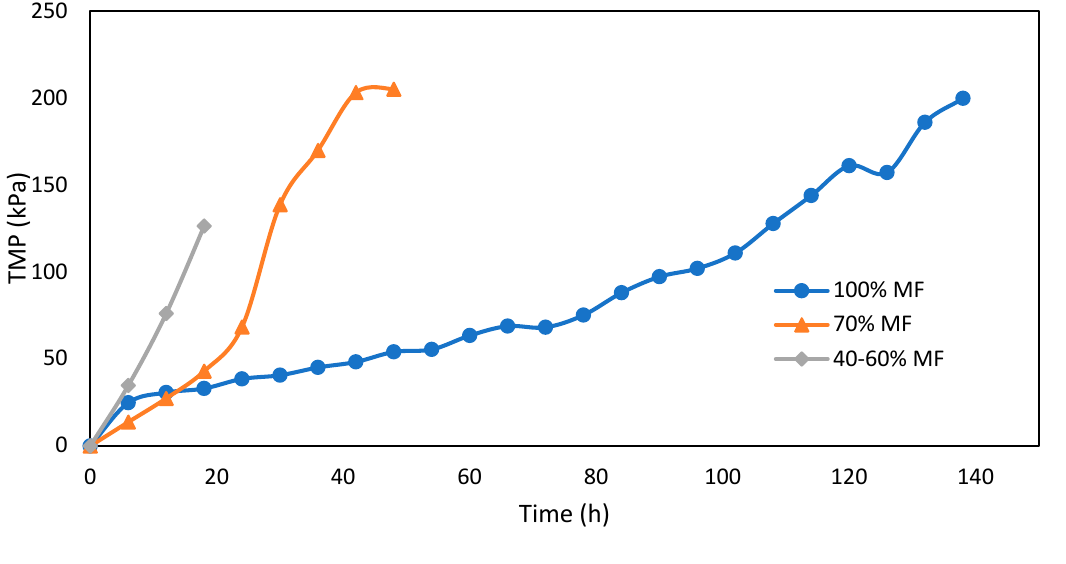
Figure 5. TMP increase during MF operation with various FO/MF extraction ratios and operation at constant flux (5 L.m − 2 .h − 1 ).